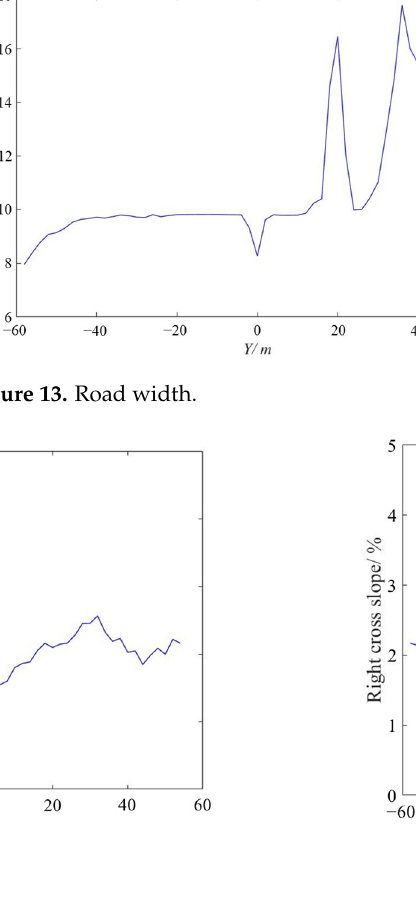
Figure 14. Cross slopes of the road. ( a ) Left cross slope; ( b ) right cross slope.